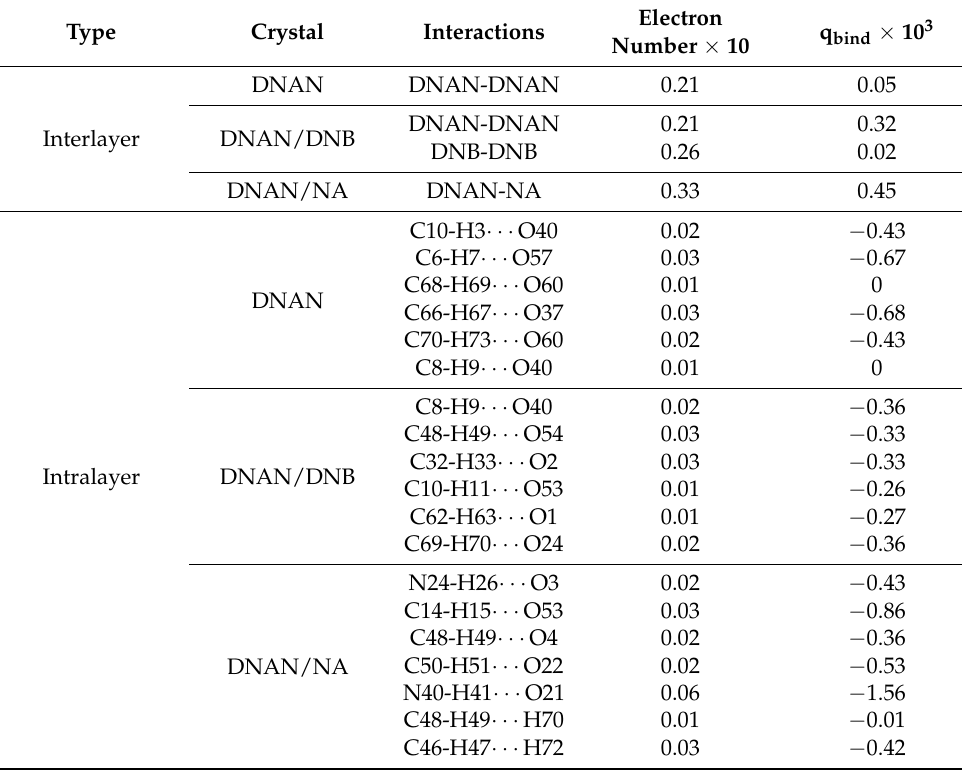
Table 3. List of electron numbers (a.u.) and q bind (a.u.) of interlayer weak interactions and intralayer intermolecular weak interactions of the three